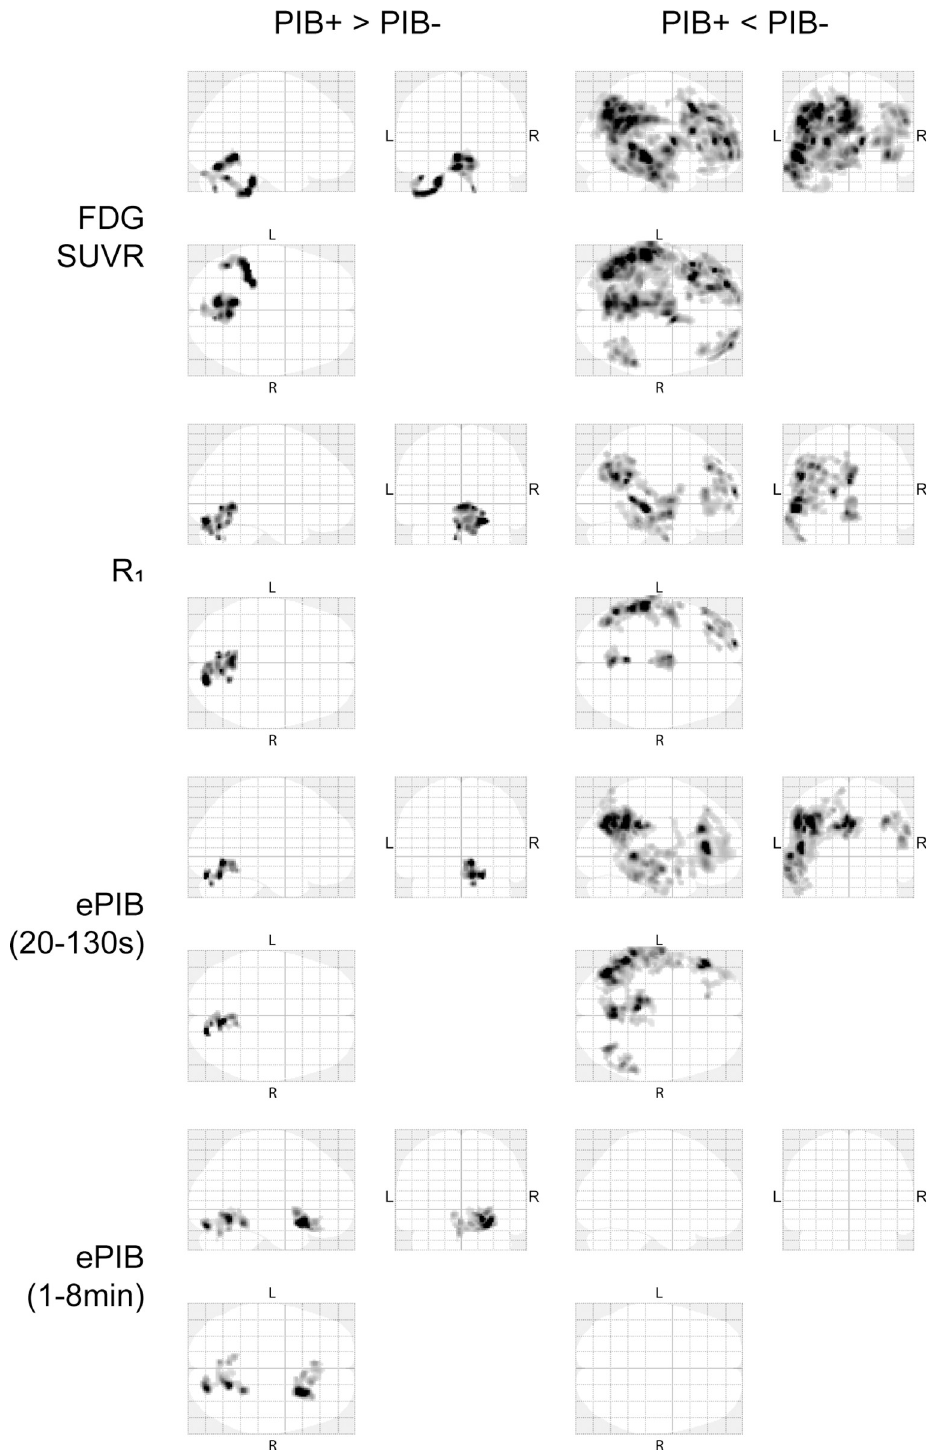
Fig 6. SPM analysis. Maximum Intensity Projections derived from the voxel based analysis. First row contains the images from FDG SUVR, second row shows R 1 , third, ePIB(20 to 130 seconds), and fourth, ePIB(1 to 8 minutes). On the left, statistically significant regions where PIB+ group shows higher rCBF than the PIB- group, and, on the right, statistically significant regions where the PIB- group showed higher flow than the PIB+ group.